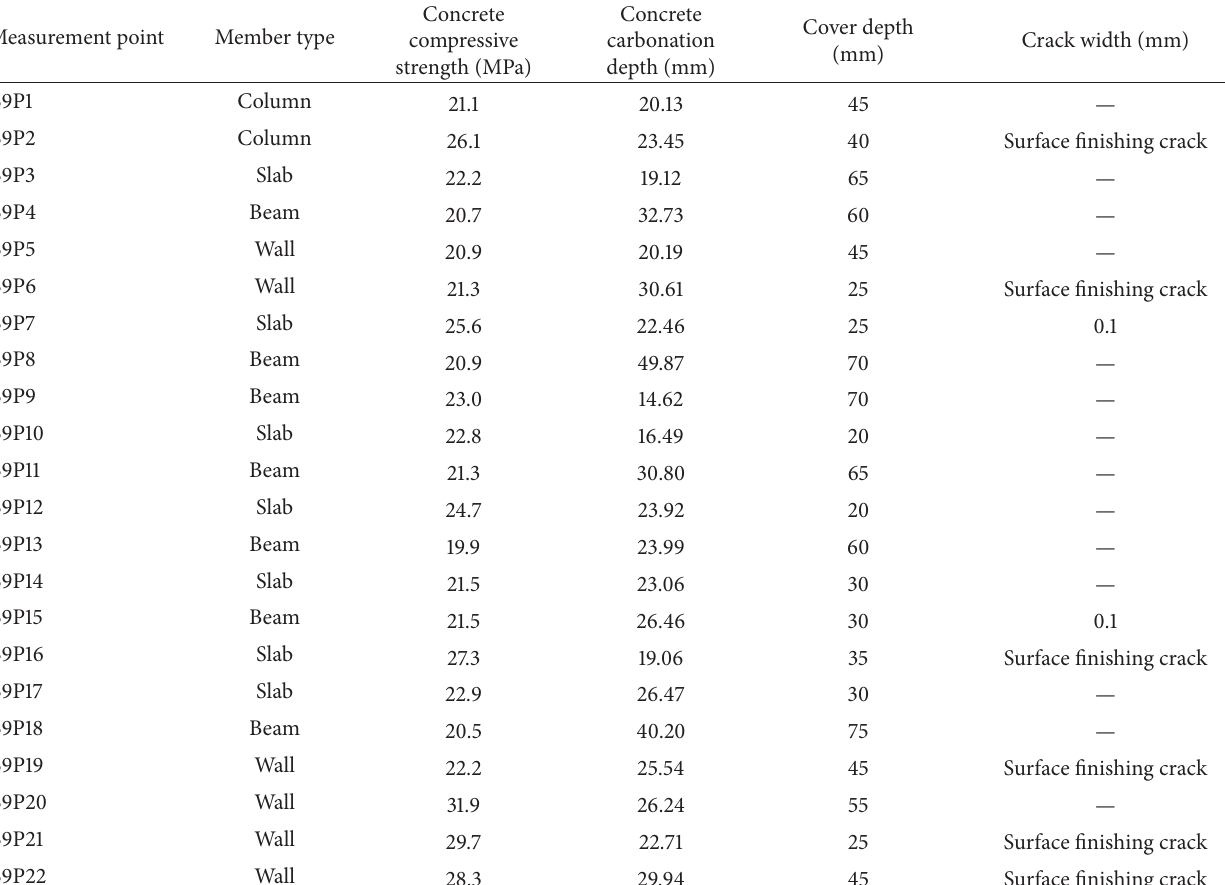
Table 1: Field investigation data (Building 9, construction completion year: